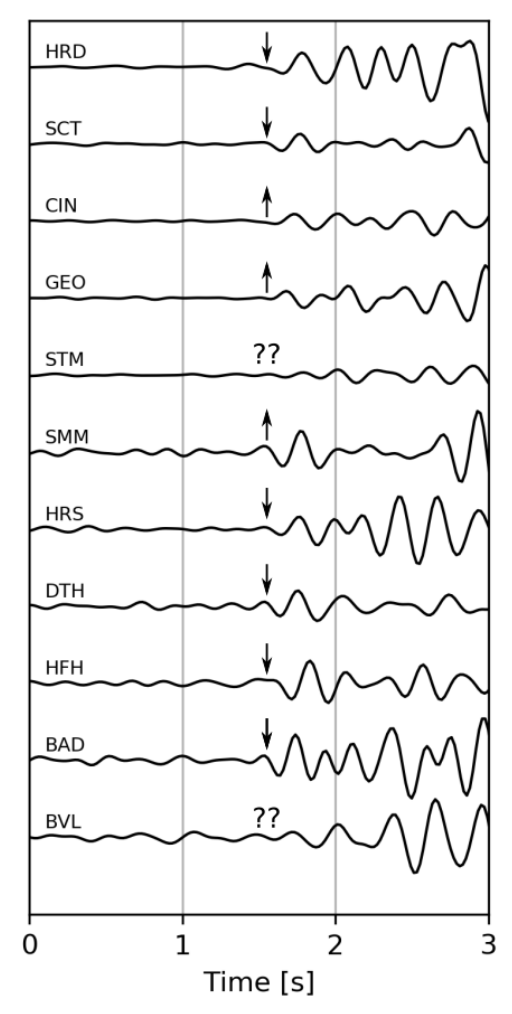
Figure 5: First arrivals of stacked waveforms of Family 1 as recorded by 11 stations in the 2015 network, band- pass filtered at 2-5 Hz. Where the first motion is un- certain, they have been marked with question